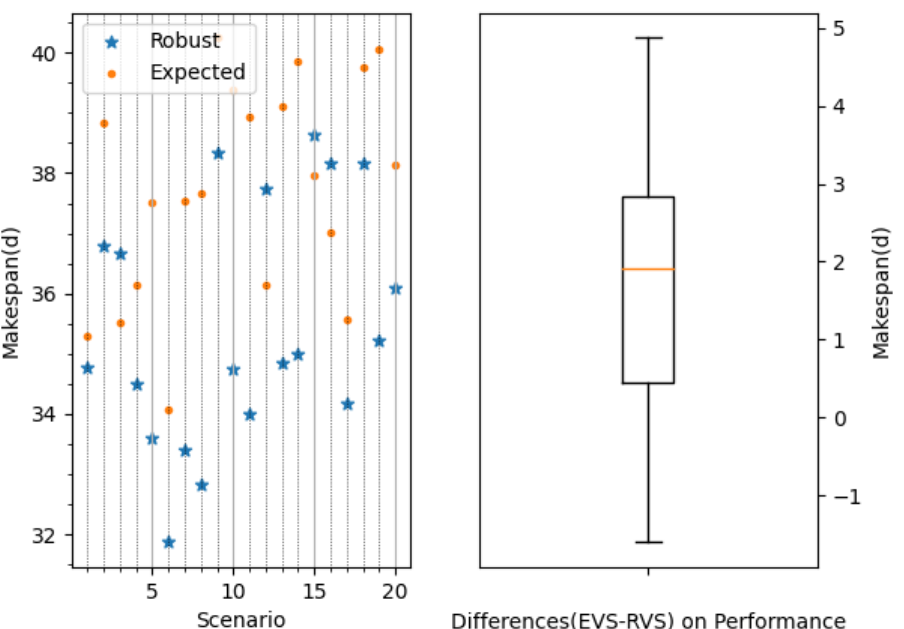
Figure 8. Performances under two approaches.